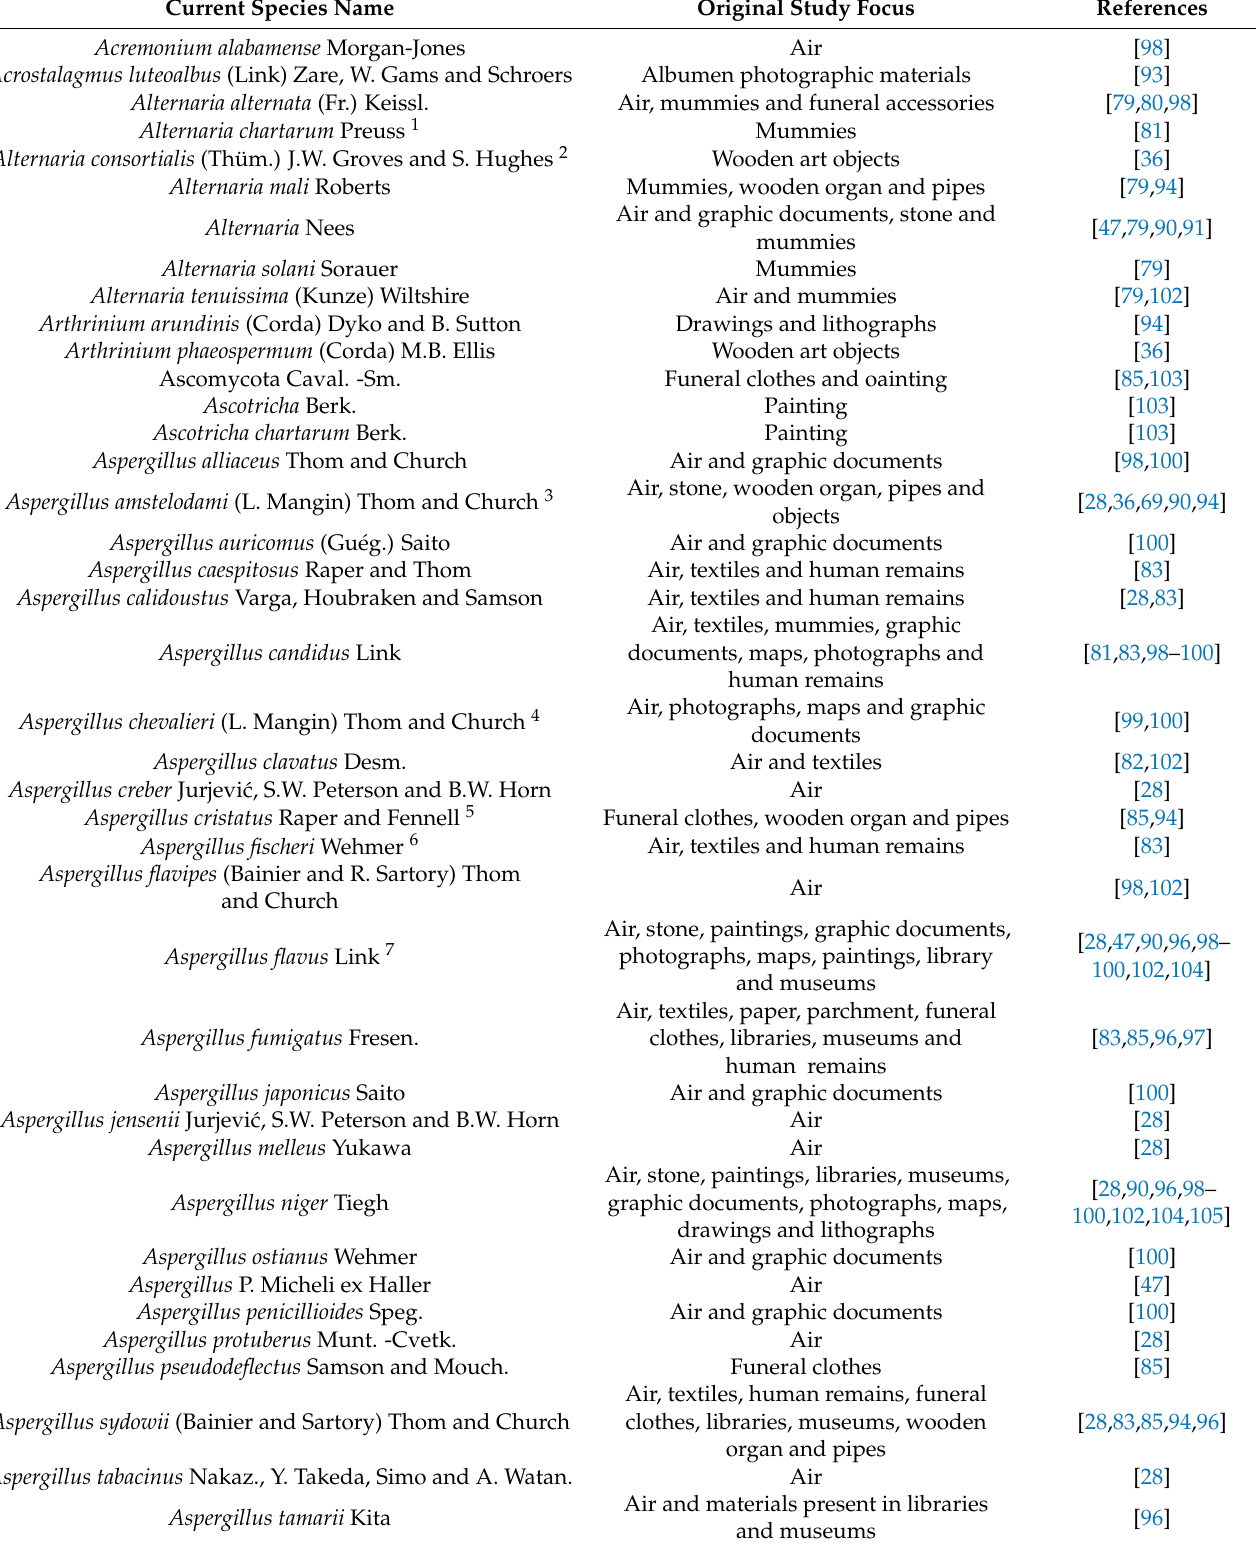
Table 9. Overview of fungal species for which isolates have been identified as displaying cellulolytic abilities in biodeterio- rative plate